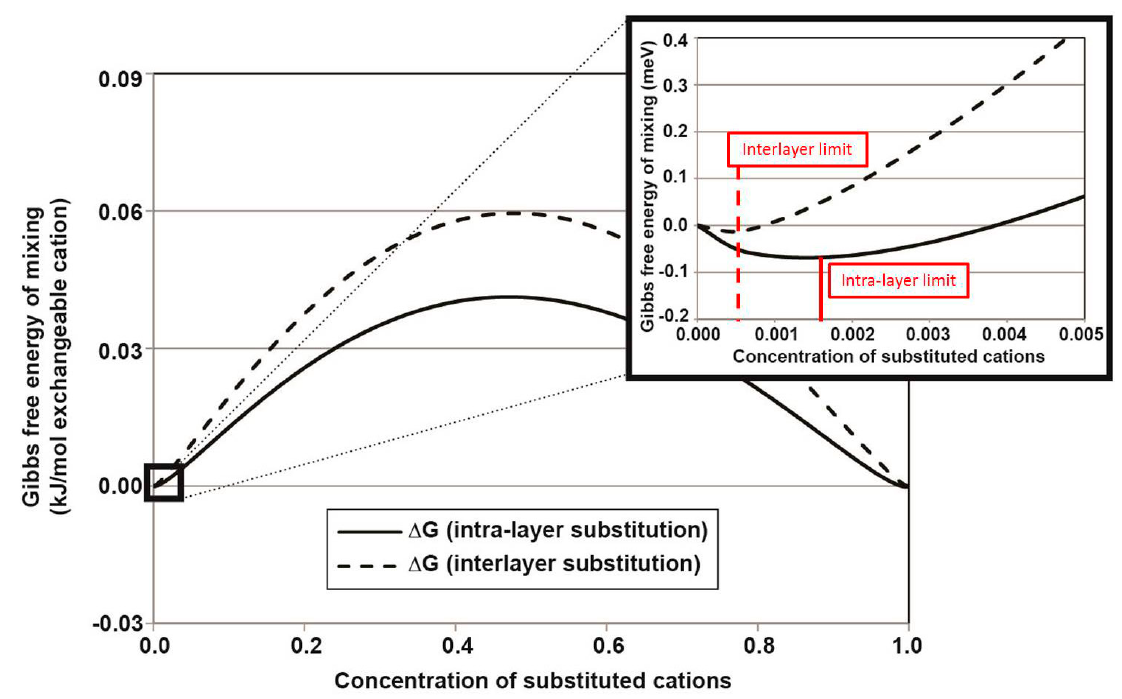
Figure 2. Gibbs free energy of mixing (Δ G boltwoodite solid solution series based on the intra-layer (solid) and interlayer (dashed) coupled substitution mechanisms. The inset highlights the negative Δ G end-member composition (modified from